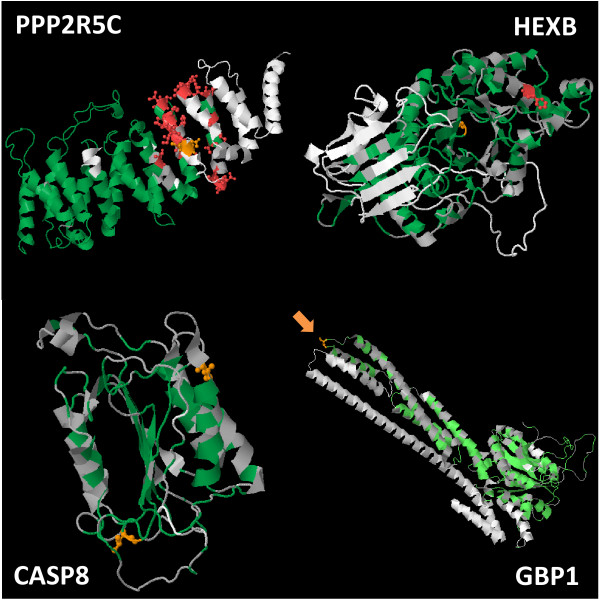
Results of positive selection calculation are visualized onto 3D structure of PPP2R5C, HEXB, GBP1 and CASP8 pig proteins. The color scale from light to dark green represents purifying selection, while orange and red represent positive selection with posterior probabilities greater than 95% or 99%, respectively. The orange arrow points to the serine at position 427 of GBP1 protein that is under positive selection.